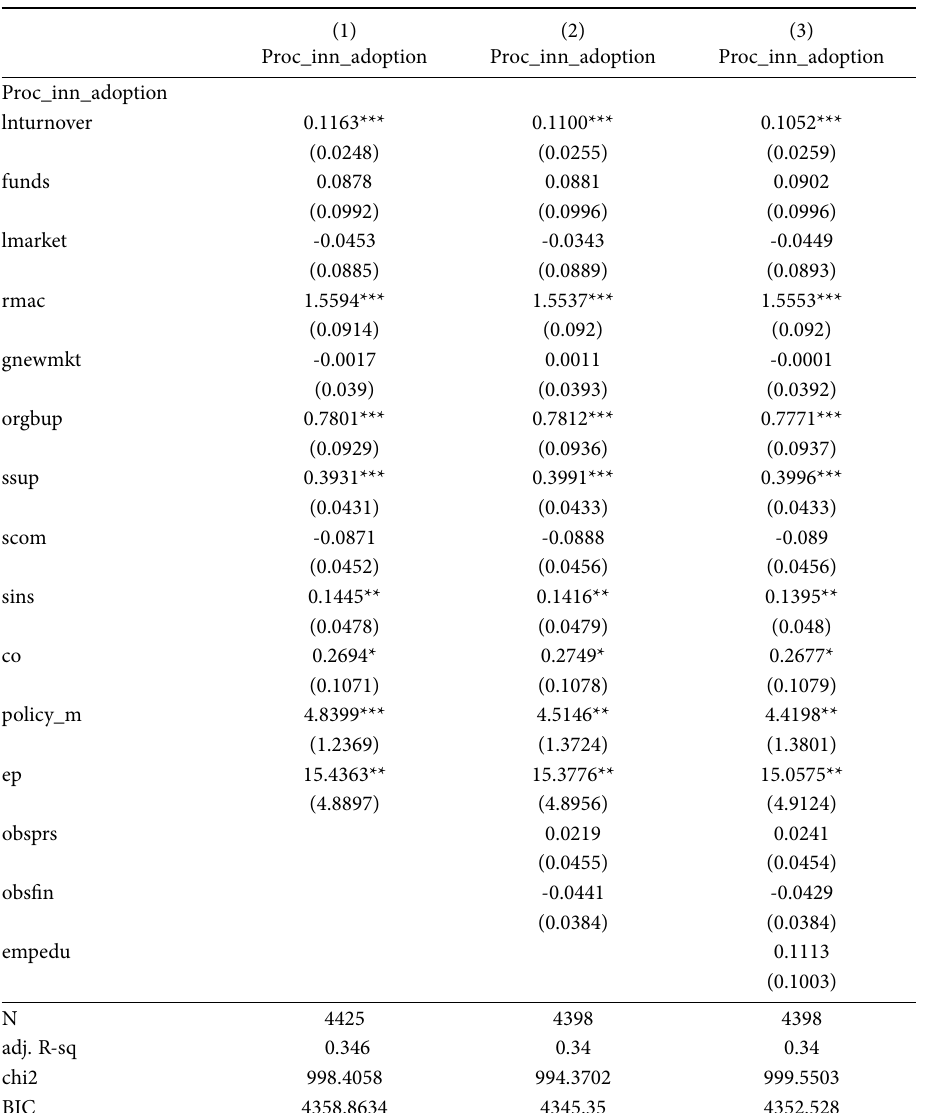
Table 5. Robustness Logit